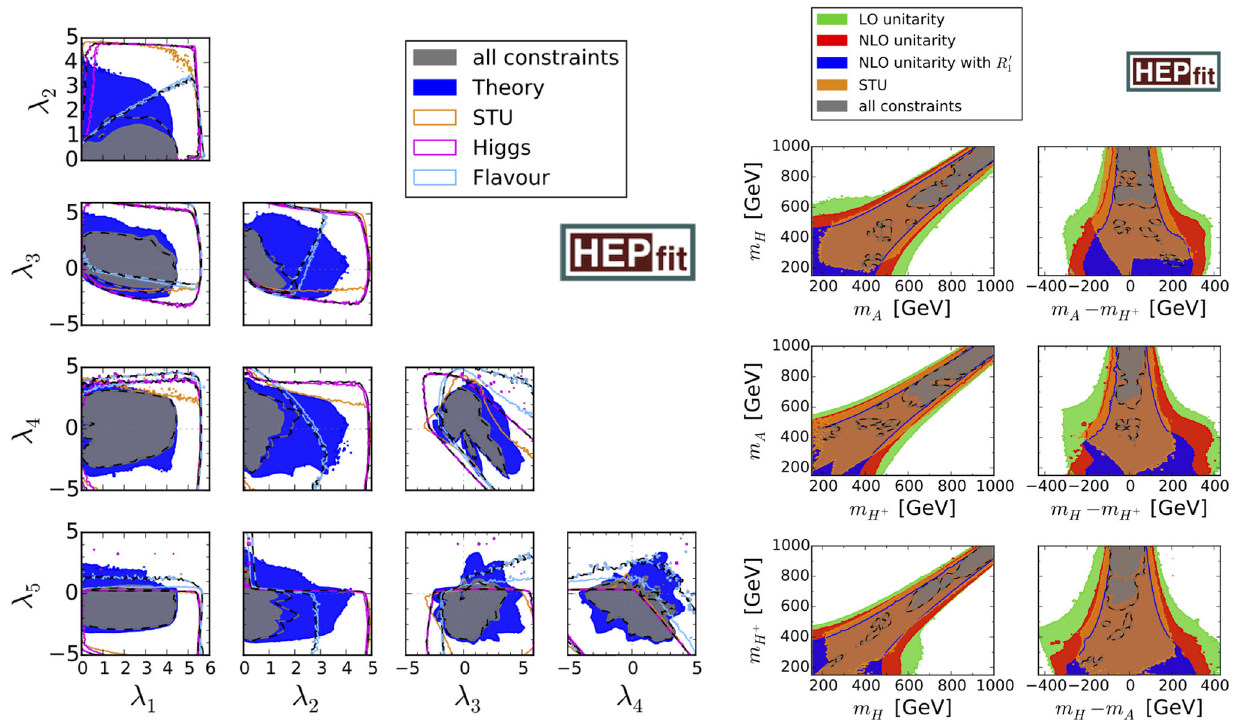
Fig. 5 Left panel: λ i vs λ j planes. The blue shaded regions are 99.7% probabilityareastakingintoaccounttheoreticalconstraintsdescribedin Sect. 4.4. Orange, pink and light blue lines mark the 95.4% boundaries of fits using only the oblique parameters (STU), all Higgs observables (strengths and direct searches) and flavour observables, respectively. The grey contours are compatible with all theoretical and experimental bounds at a probability of 95.4%. The solid lines are understood as the